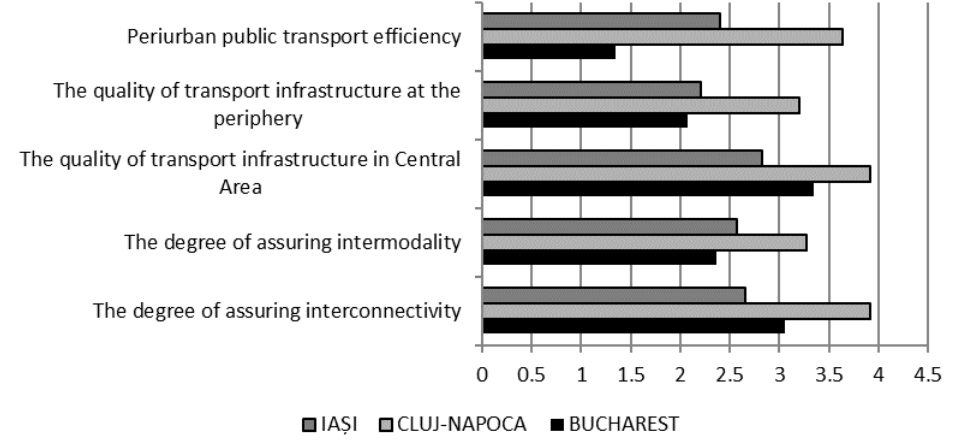
Figure 5: The average scores for different topics of urban transport in the analysed cities The adoption of different solutions for increasing the efficiency of urban transport from both technological and ecological points of view is also different ly perceived among the three cities.